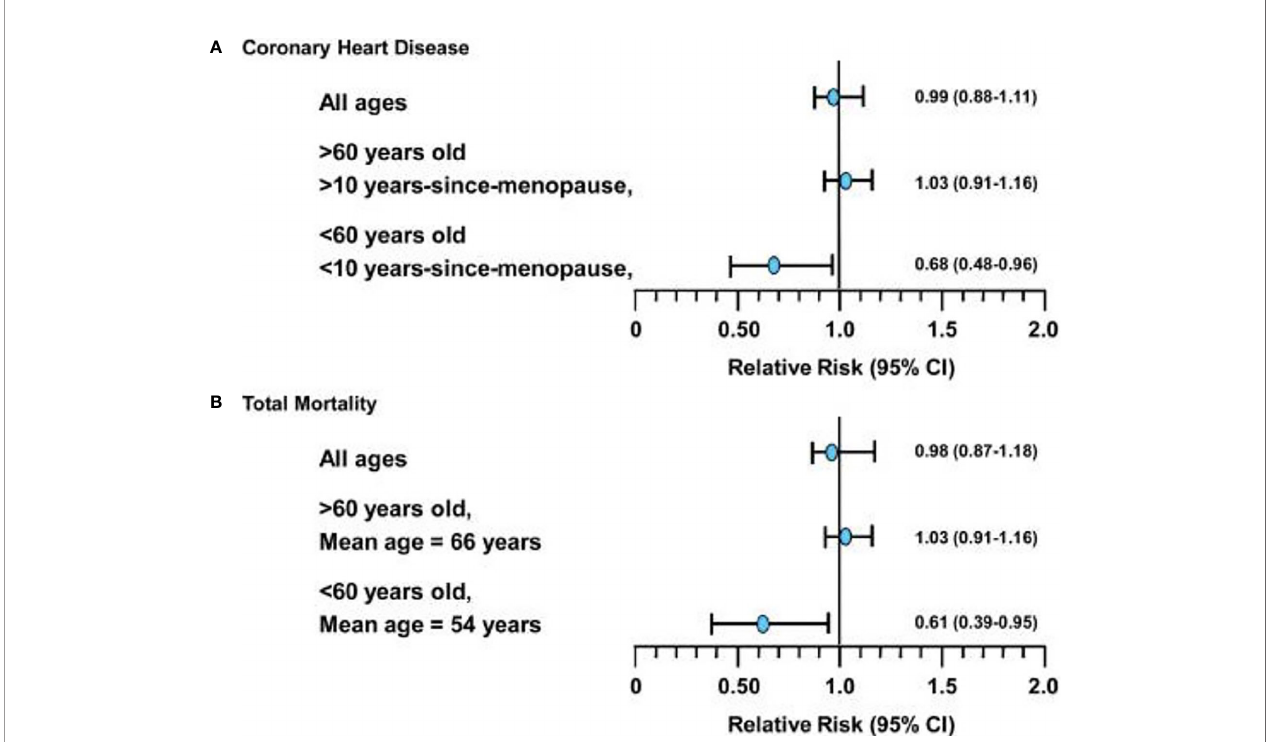
FIGURE 1 | (A) Relative risks (and 95% con fi dence intervals) for coronary heart disease events associated with hormone replacement therapy from meta-analysis of 23 randomized controlled trials in 39,049 women (followed for 191,340 women-years). (B) Relative risks (and 95% con fi dence intervals) for total mortality associated with hormone replacement therapy from meta-analysis of 30 randomized controlled trials in 26,708 women (followed for 119,118 women-years). *Figure used with permission by John Wiley and Sons (License: 4838400238207) and from Dr. Howard Hodis from Hodis HN, Mack WJ. The timing hypothesis: a paradigm shift in the primary prevention of coronary heart disease in women: part 1, comparison of therapeutic ef fi cacy. J Am Geriatr Soc.